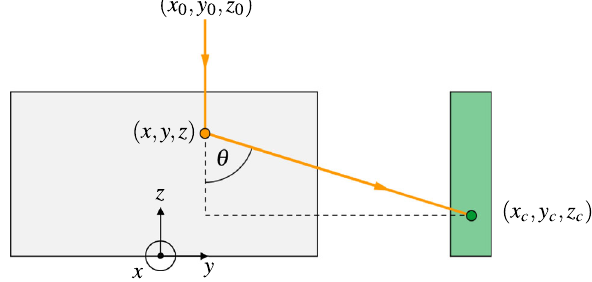
Fig. 1 Schematic of a typical gamma trajectory in the Compton Scan- ner: The gamma is emitted by the source at ( x 0 , y 0 , z 0 ) , Compton scat- ters inside the germanium detector at ( x , y , z ) and is fully absorbed in the camera at ( x c , y c , z c ) . The Cartesian coordinate system is defined such that the y axis is parallel to the line which connects the centers of the detector and the camera, and the z axis is parallel to the beam. The origin of the Cartesian coordinate system is located at the center of the bottom surface of the